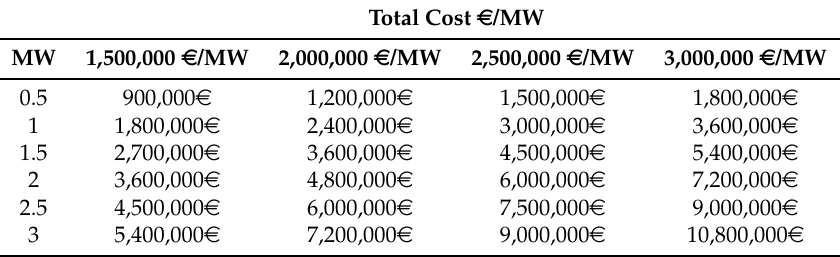
Table 1. Estimated total CapEx for different installed capacities and costs, values include facility re-powering.